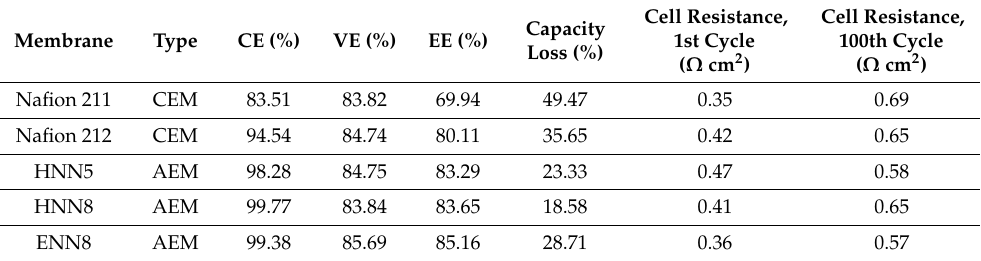
Table 2. VRFB performance over 100 cycles using different ion-exchange membranes.